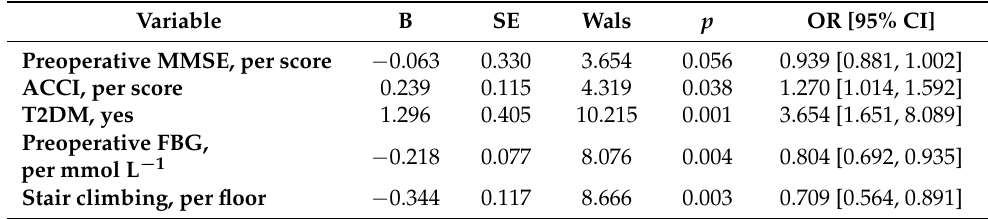
Table 7. Multivariable logistic